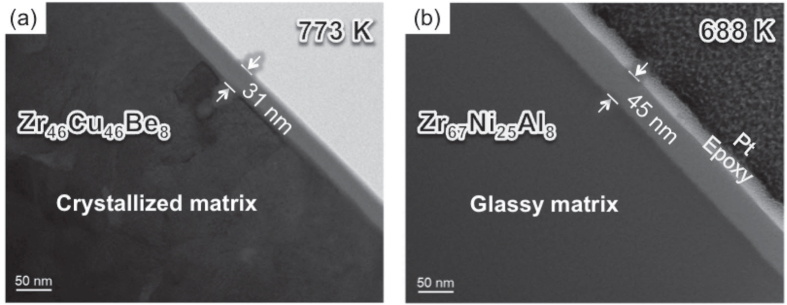
Cross-sectional bright field TEM images obtained from (a) the Zr46Cu46Be8 and (b) the Zr67Ni25Al8 alloys showing the thickness of the oxide films after continuous heating up to 773 K (32 K above Tx) and 688 K, respectively.